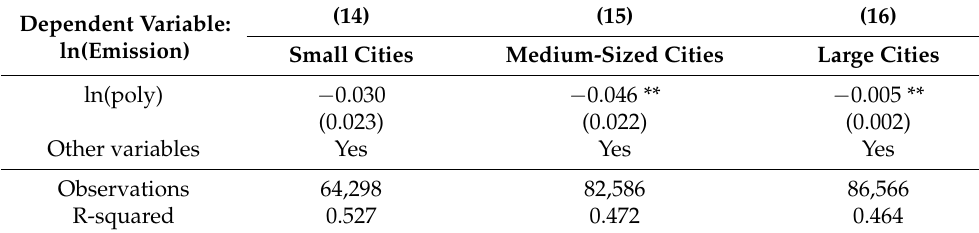
Table 6. City-size tests.